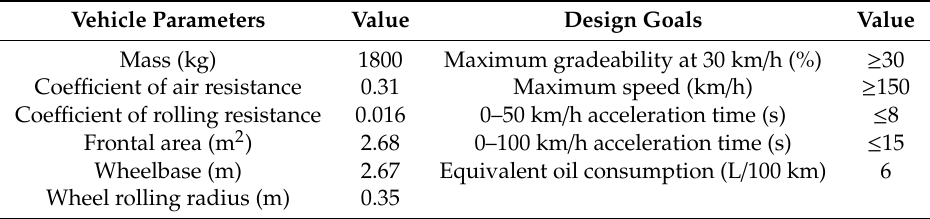
Table 1. Main vehicle parameters and design